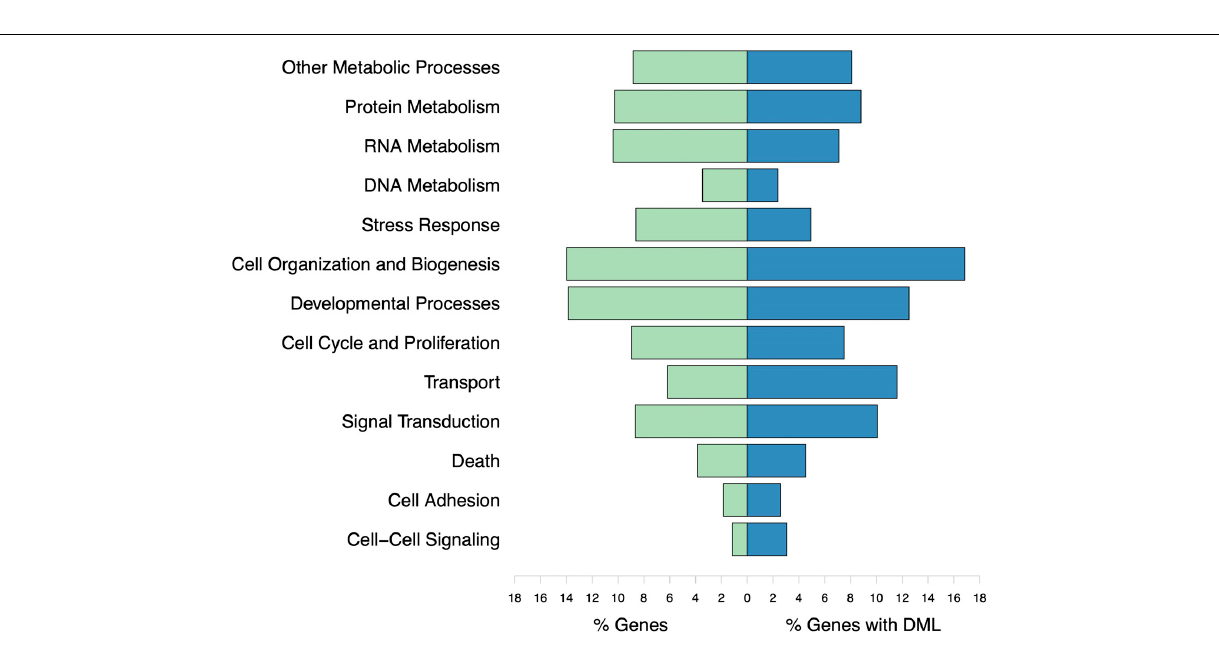
FIGURE 8 | Biological processes represented by all genes used in enrichment background (% Genes) and those with DML (% Genes with DML). Gene ontology categories with similar functions are represented by the same color. Genes may be involved in multiple biological processes. No gene ontologies were significantly